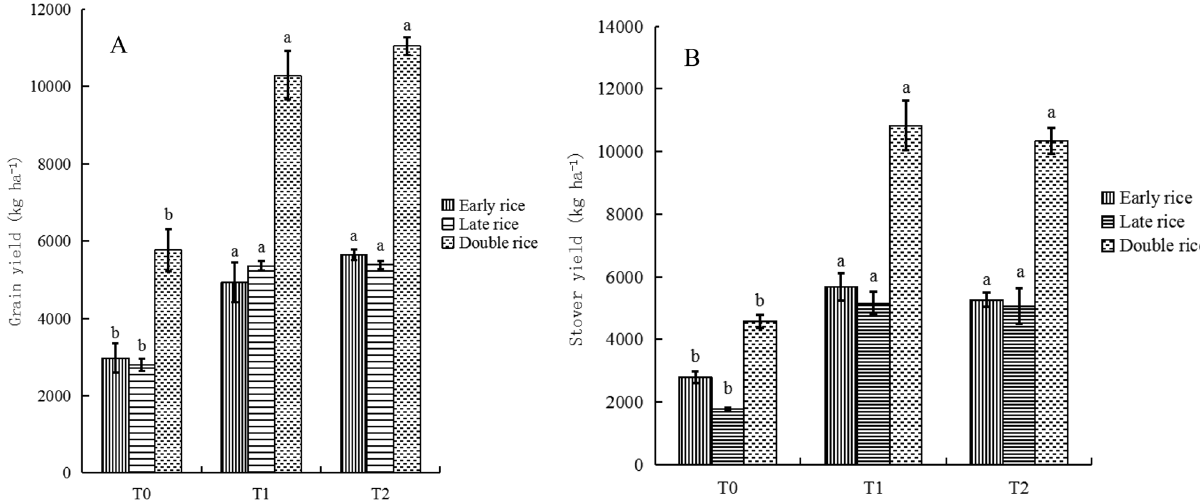
Figure 1. Grain ( A ) and stover ( B ) yield of rice as influenced by fertilization and irrigation in 2018. Notes : T 0 = Traditional irrigation; T 1 = Traditional irrigation and fertilization practice; T 2 = Water-saving irrigation and optimizing fertilization. The different lower-case letters indicate significant differences between different treatments at P < 0.05 according to Duncan multiple range test. Error bars show SE ( n = 3).